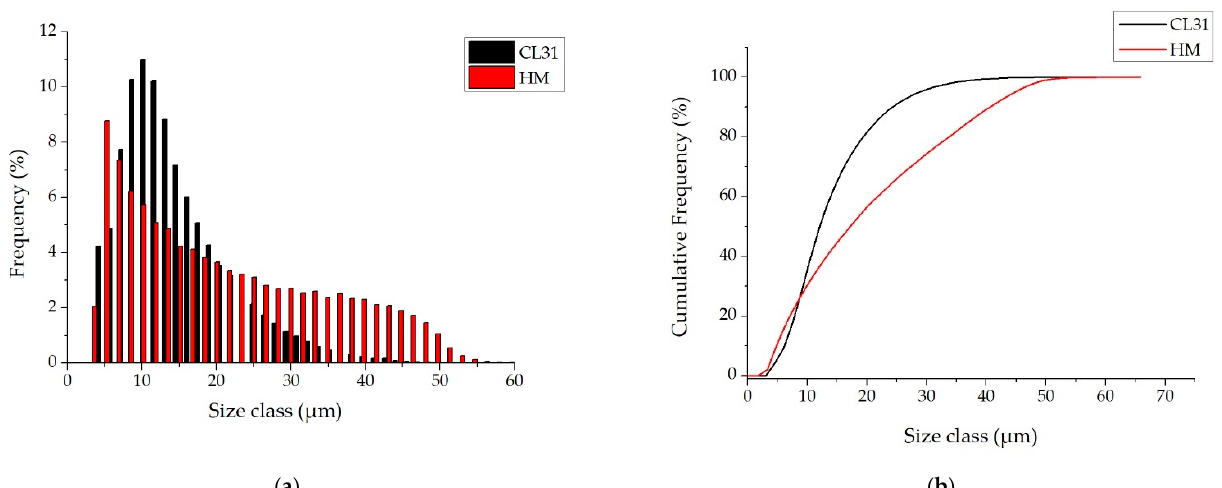
Figure 2. PSDs number of the CL31 and HM powders. ( a ) relative PSD frequency and ( b ) cumulative PSD frequency.